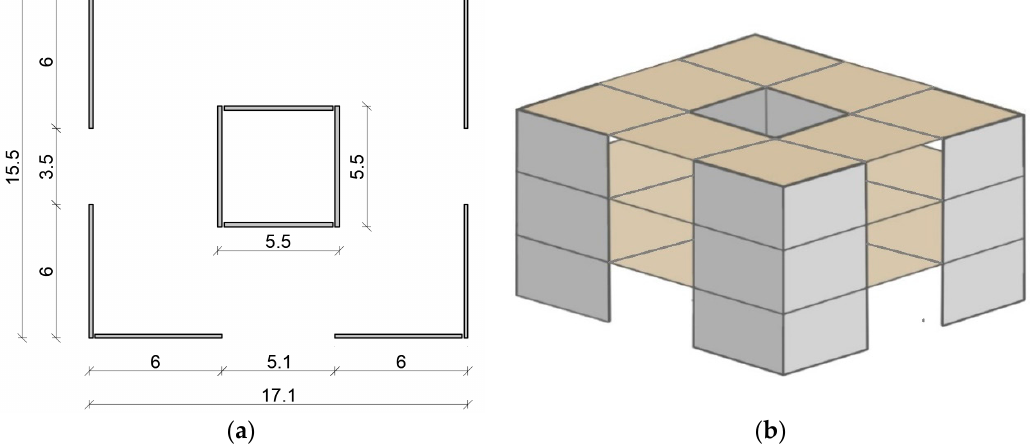
Figure 3. Reference building: ( a ) building footprint and shear-wall arrangement; ( b ) axonometric view (dimensions in m).